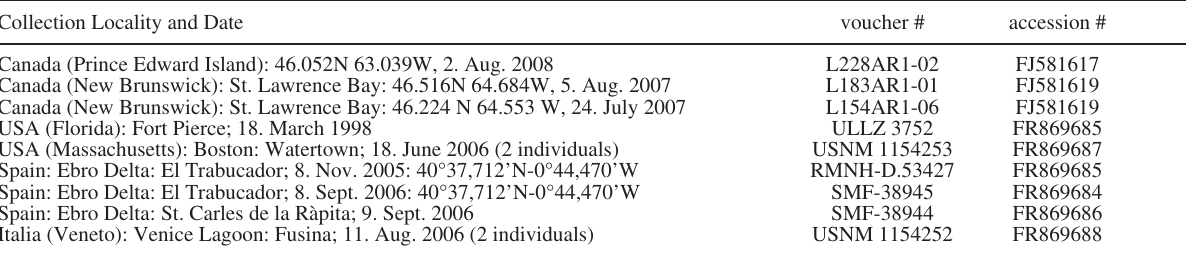
Table 2. – Origin of specimens of Dyspanopeus sayi (Smith, 1869) used for genetic analyses and comparison of 658 basepairs of the mitochondrial Cox1 gene. Specimens from Canada from Radulovici et al . (2009) (RMNH: Naturalis Museum, Leiden; SMF: Senckenberg Museum und Forschungsinstitut, Frankfurt; ULLZ: University of Louisiana at Lafayette Zoological Collection, Lafayette; USNM: National Museum of Natural History of the Smithsonian Institution, Washington DC). Collection Locality and